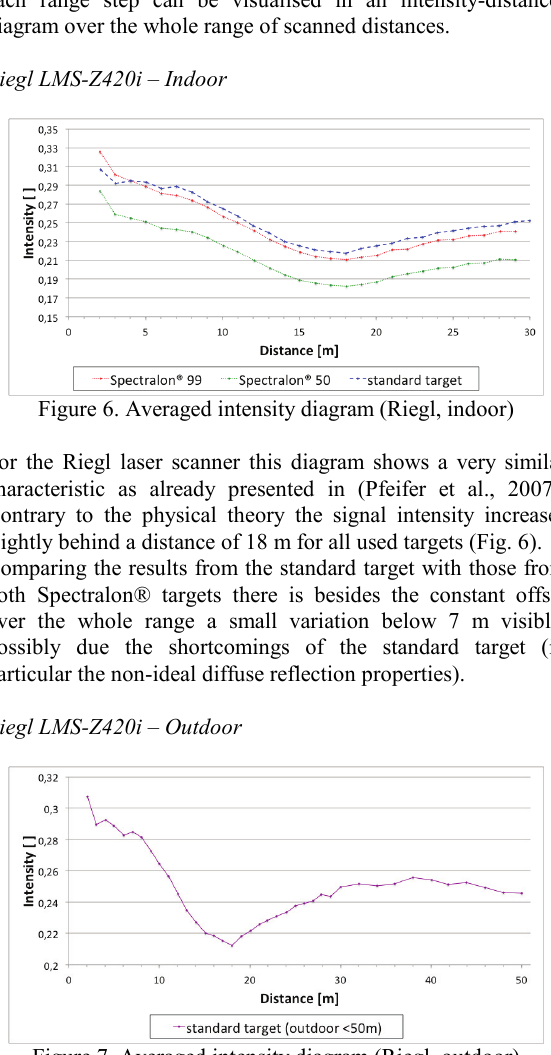
Figure 7. Averaged intensity diagram (Riegl,